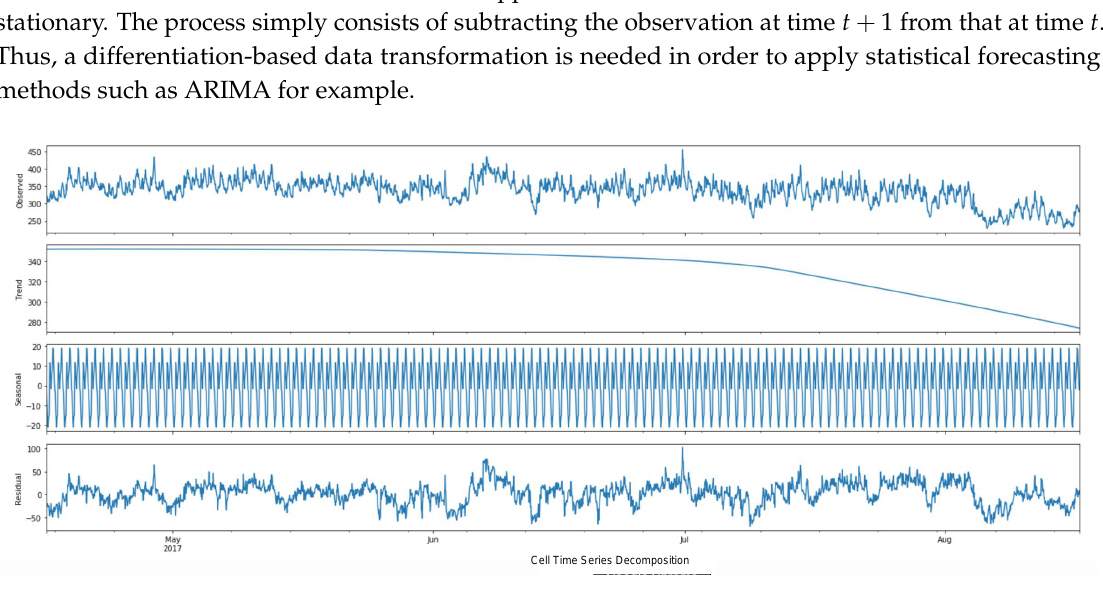
Figure 6. This figure shows the STL decomposition of the time series of one cell in the grid. Each time-series of a cell can be expressed as the sum of its components: trend, seasonal and residual.